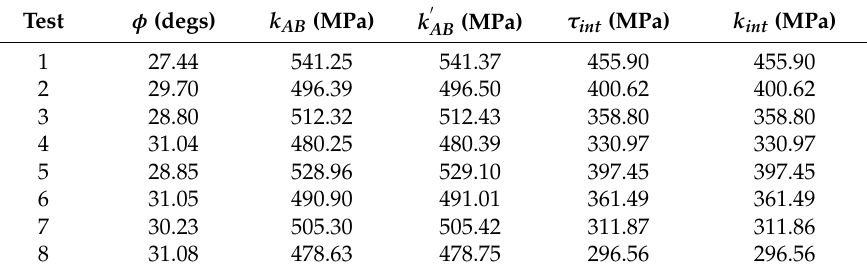
Table 4. Calculated shear angle and stresses at the PSZ and